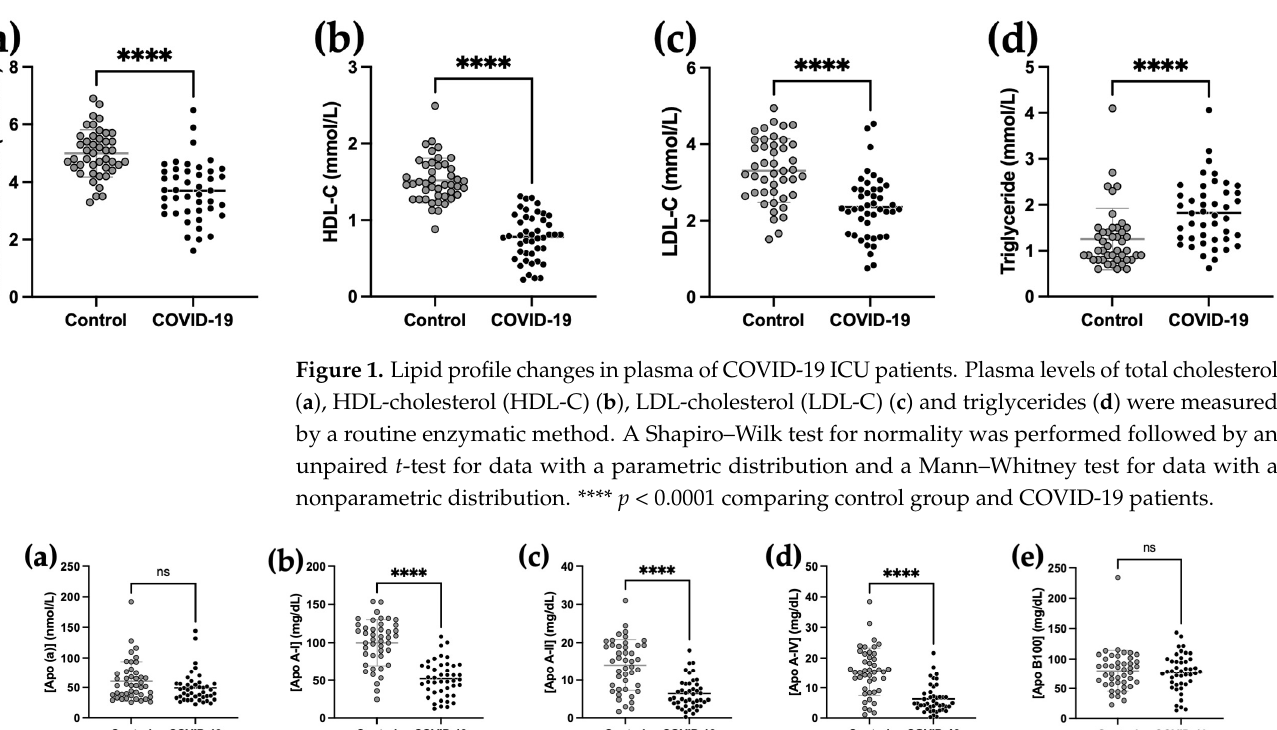
Figure 1. Lipid profile changes in plasma of COVID-19 ICU patients. Plasma levels of total cholesterol ( a ), HDL-cholesterol (HDL-C) ( b ), LDL-cholesterol (LDL-C) ( c ) and triglycerides ( d ) were measured